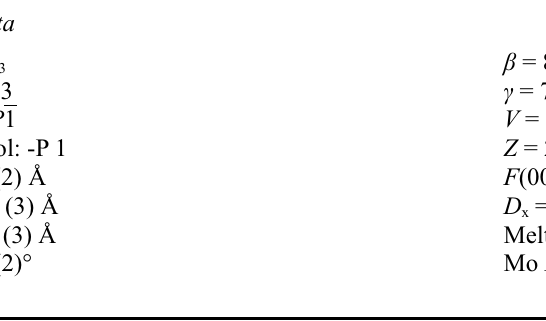
Molecular structure with displacement ellipsoids drawn at 35% probability for non-H